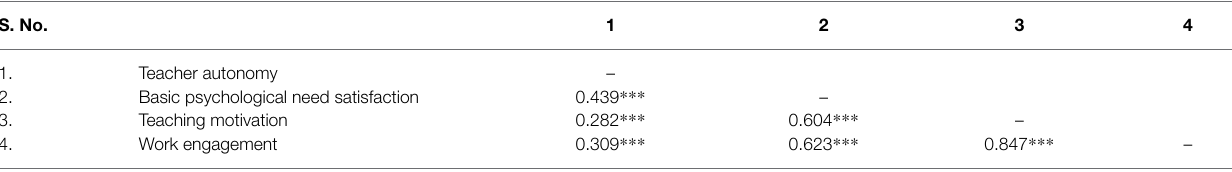
TABLE 3 | Correlation analysis for main variables ( n =